Question: Produce a descriptive caption suitable for publication.
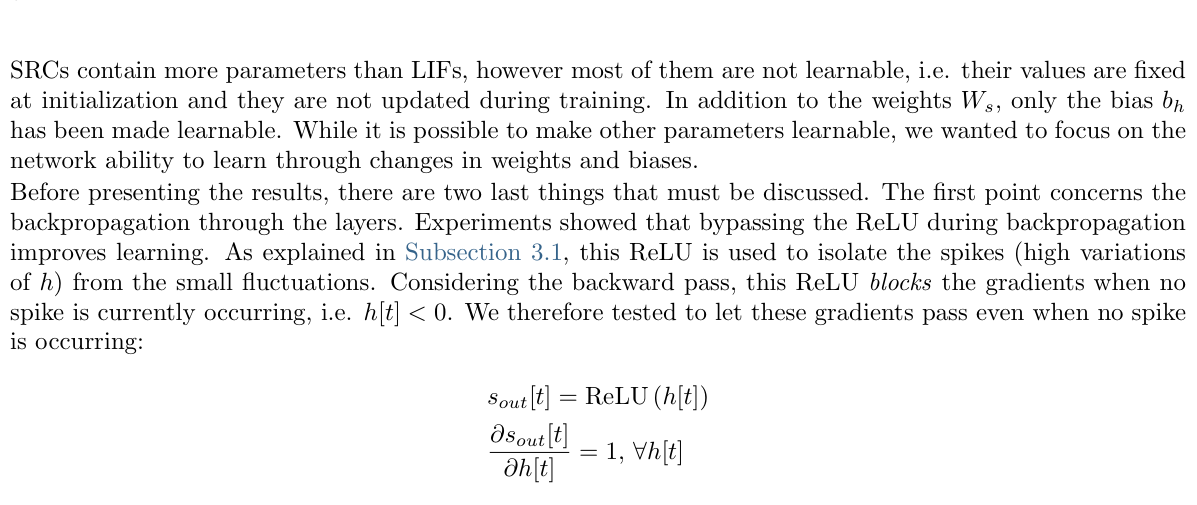
Answer: Evolution of the training cross-entropy and the validating accuracy on the MNIST dataset for two sets of networks composed of 5 SRC layers. For one set, the ReLU has been skipped during the backpropa- gation.